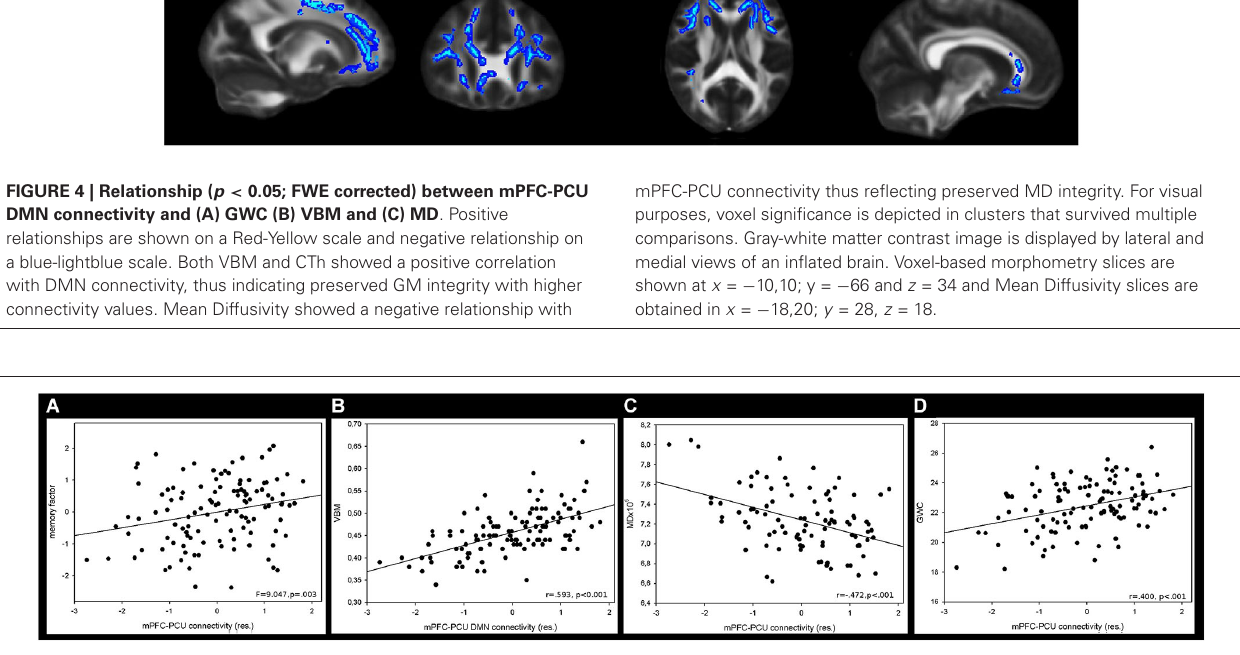
FIGURE 5 | Mean correlation between mPFC-PCU DMN connectivity and (A) memory factor, (B) VBM, (C) MD and (D) GWC . Neuroimaging measures were obtained by calculating the mean value of the largest significant cluster (see Table 4 , Figure 4 ).